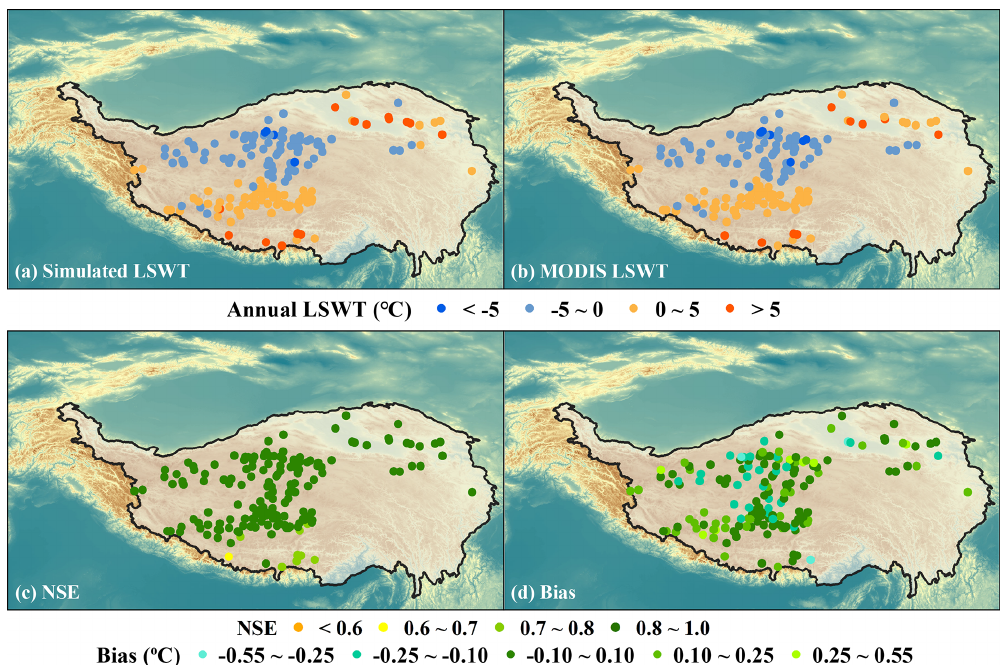
Figure 5. Spatial comparison between MOD11A1-based (a) and reconstructed (b) annual mean LSWT and spatial distribution of model performance evaluated by NSE (c) and bias (d)